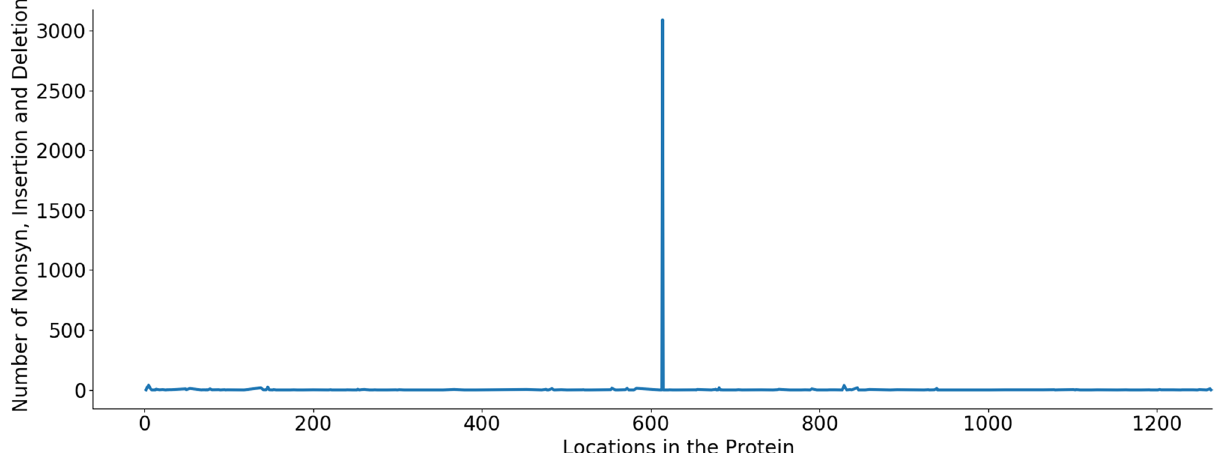
Figure 3. Protein S—The number of insertion, deletion and nonsynonymous mutations at different locations in the protein. A spike at location D614G (3089) while other regions of the protein are stable.